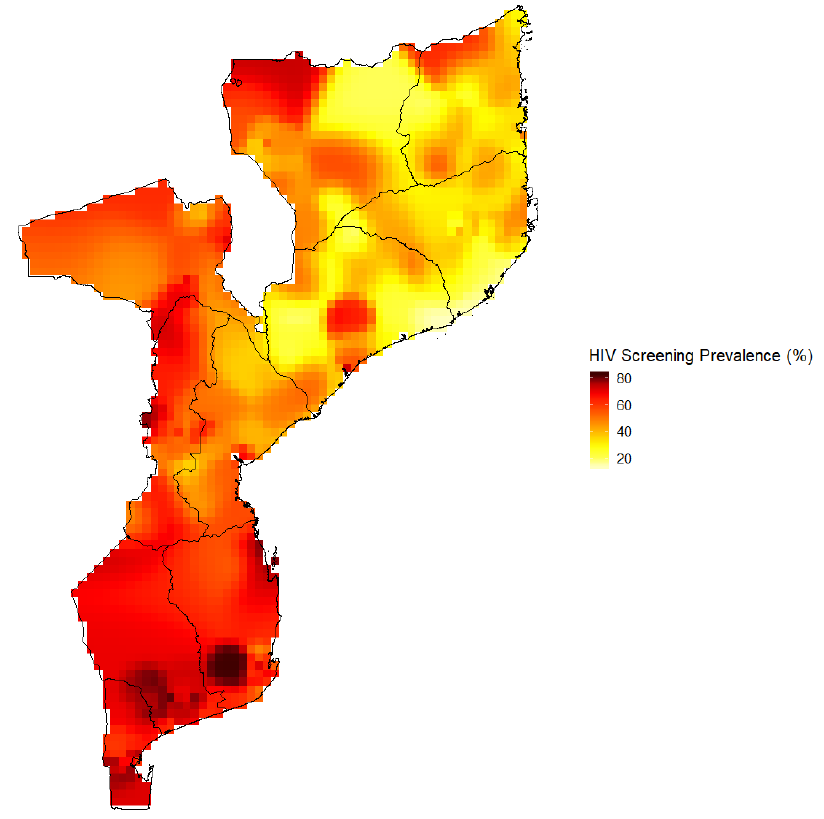
Figure 2. HIV screening prevalence in Mozambique estimated by the kernel estimator approach.